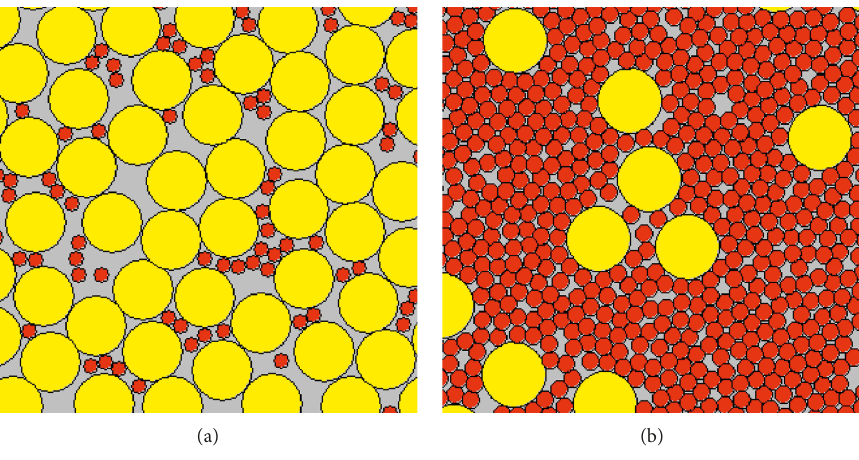
Figure 5: Packing structures for binary